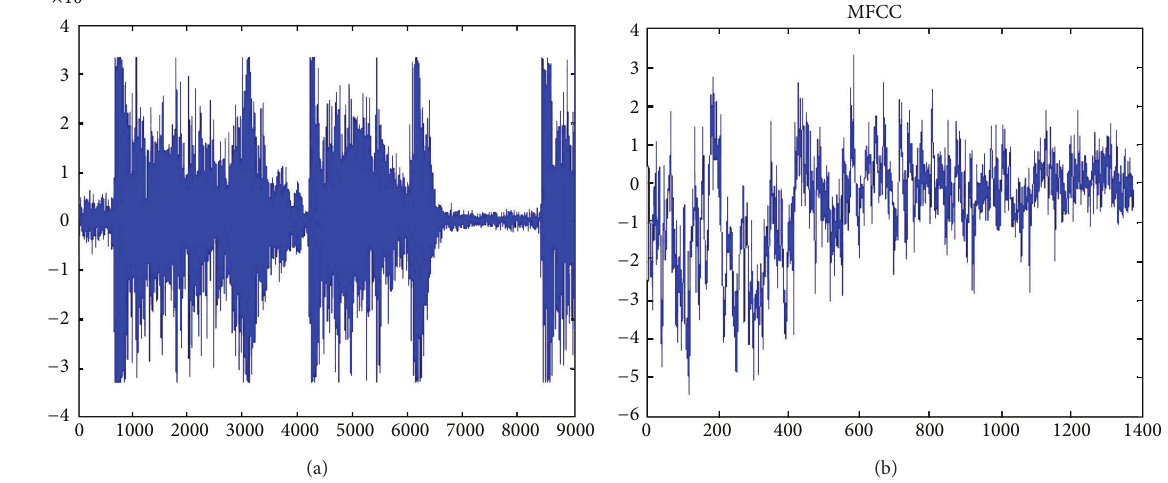
Figure 4: (a) A cough signal of an asthmatic patient and (b) its MFCC.